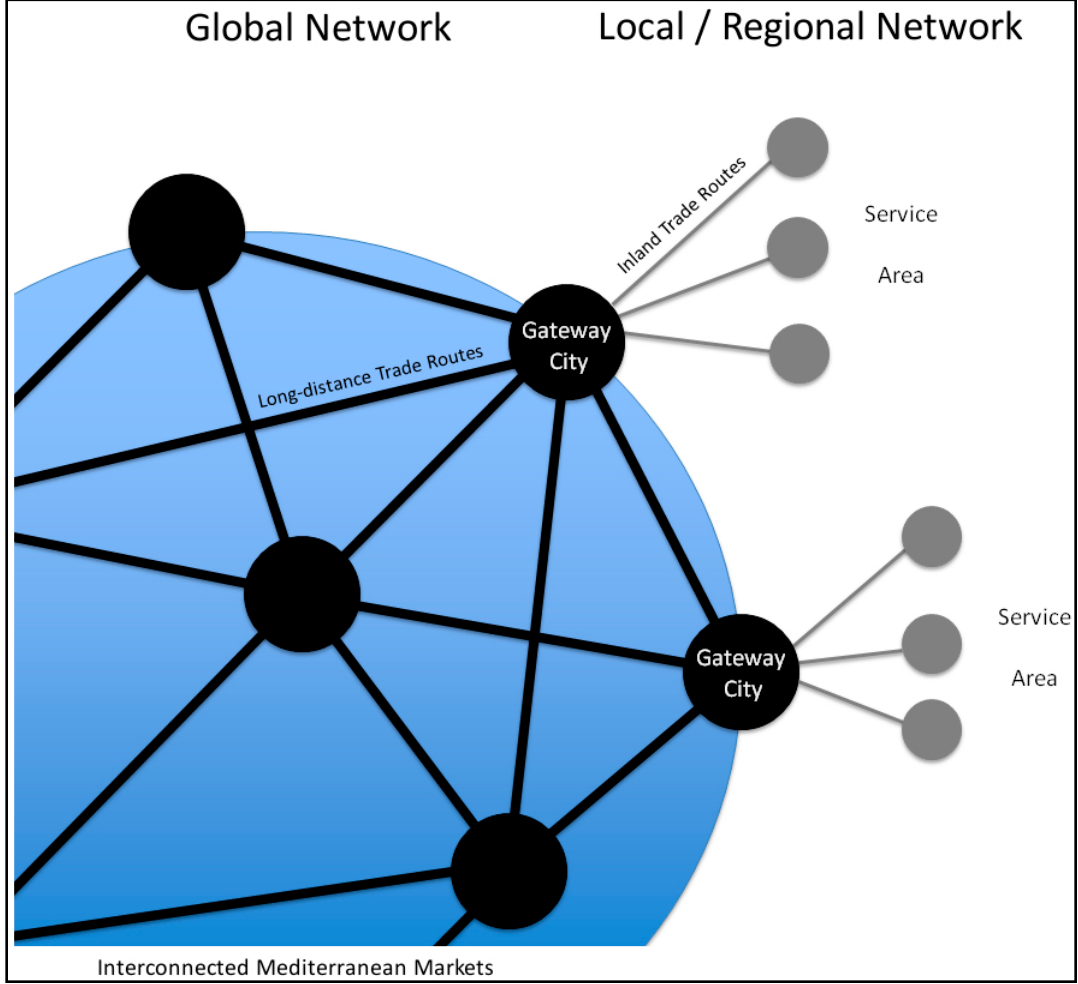
Figure 1. Scheme of port cities acting as gateways between two different market networks.